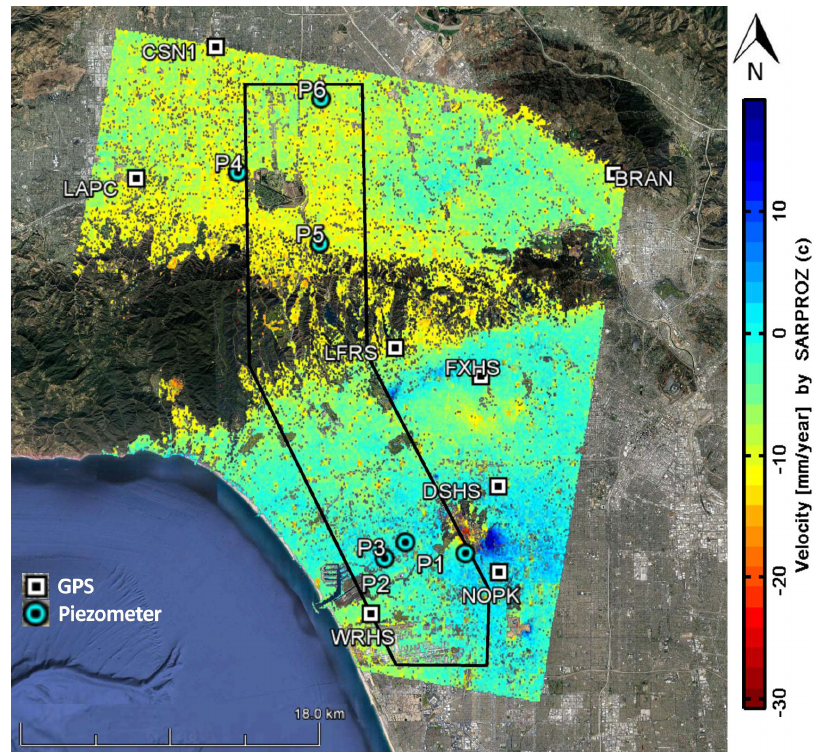
Figure 7. The location of GPS stations (squares) and piezometers (circles) in the study area.